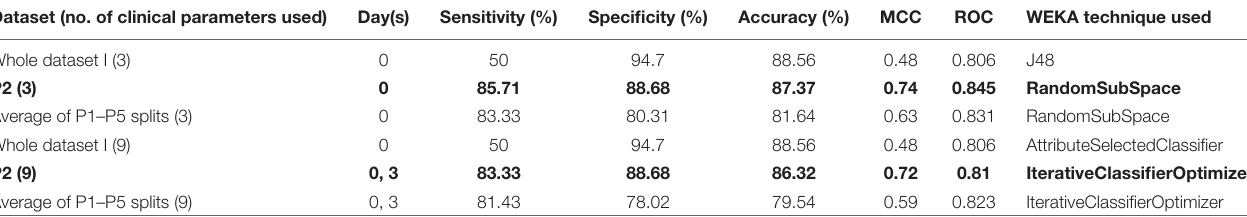
TABLE 2 | Performance of best models based on selected clinical parameter values.